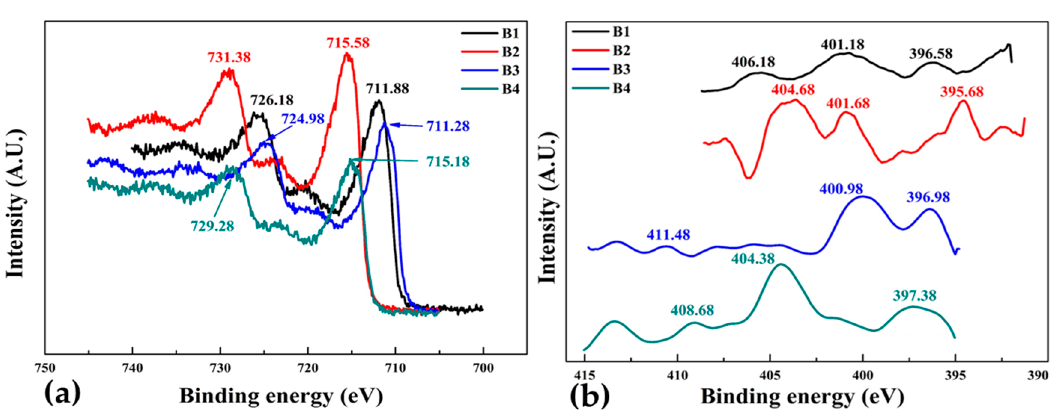
11 of 19 Figure 10. X-ray photoelectron spectra of group 1 thin films ( a ) Ag 3 d; ( b ) Fe 2 P; and ( c ) Cu 2 P. Figure 11 a,b illustrates the XPS Fe 2 p and N1s spectra for FeN thin film samples B1, B2, B3 and B4 deposited under varying nitrogen flow rates given in Table 1. There are two prominent Fe 2 p peaks (b) for all samples at binding energies ranging from 711.28 and 731.38 eV, are associated with Fe2 +